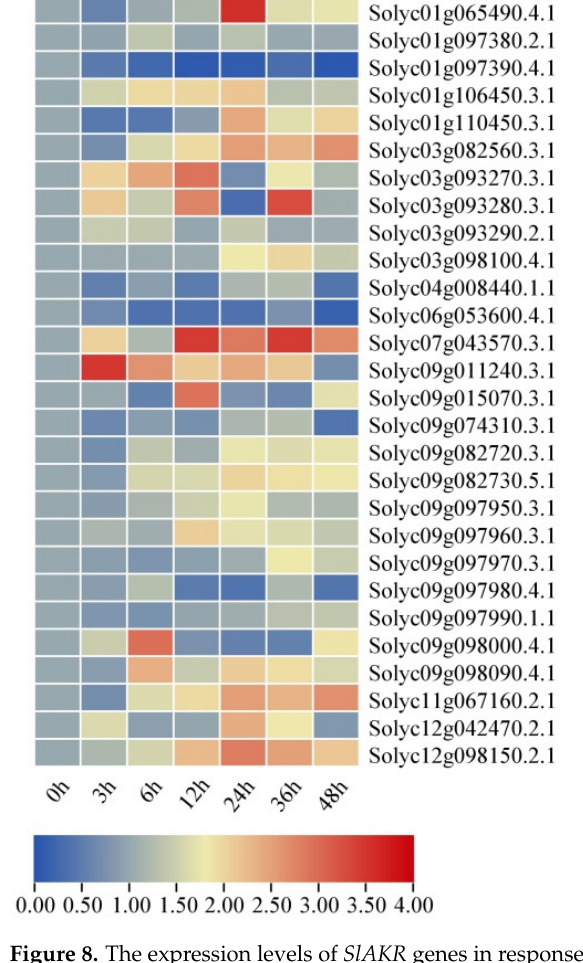
Figure 9. The expression levels of SlAKR genes in response to salt stresses treated with 200 mM NaCl for different times, such as 0, 3, 6, 12, 24, 36, and 48 h, with dd H 2 O as a control in AC.